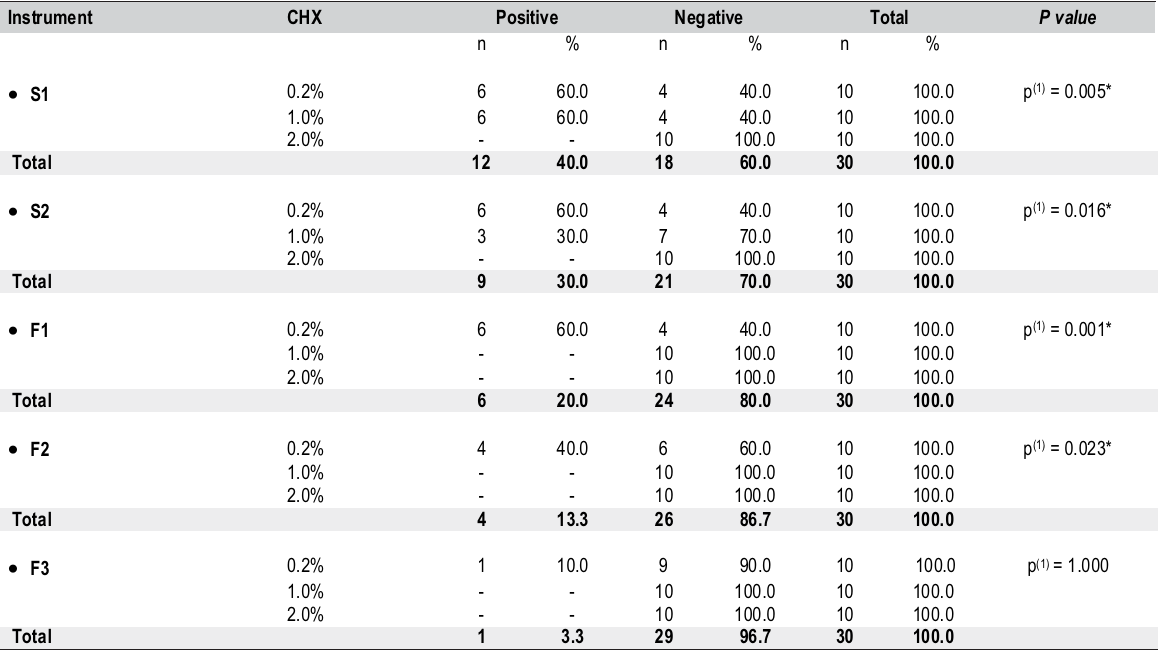
Table 2. Antimicrobial efficacy of 0.2%, 1%, and 2% CHX in root canals infected by P. aeruginosa